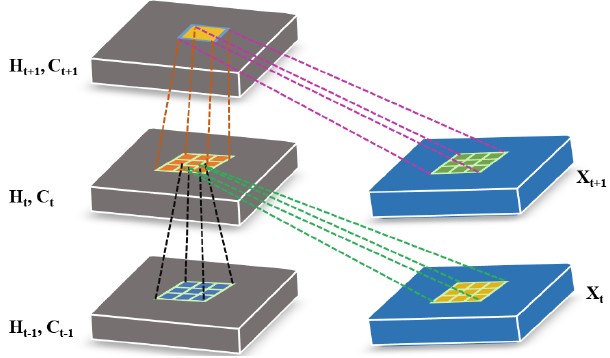
Figure 1. The inner structure of